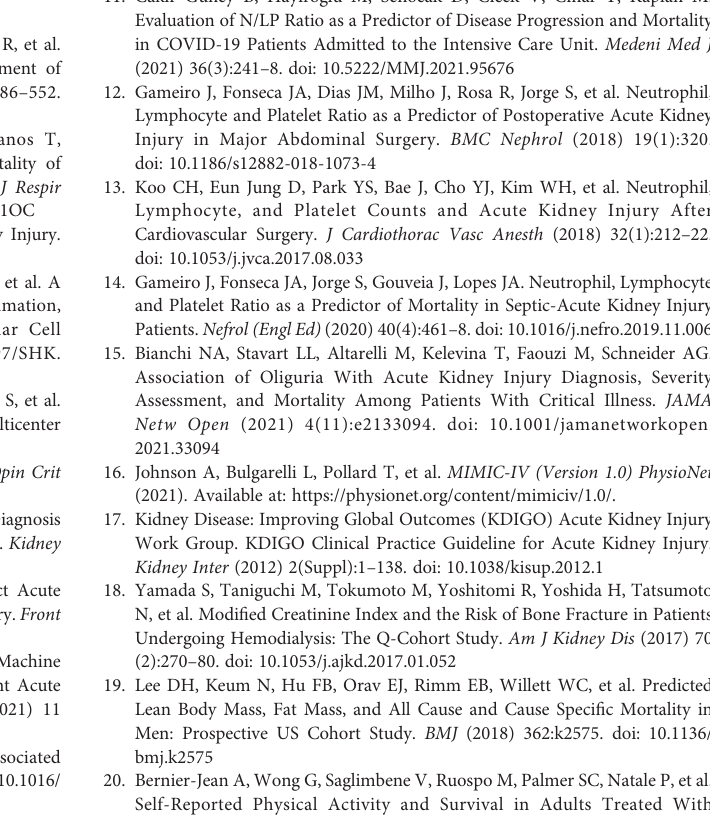
Supplementary Figure 10 | (A) The results of univariate and multivariate logistic regression. Model 1 represents the univariate analysis; Model 2 represents the multivariate analysis adjusting all covariates; Model 3 represents the multivariate analysis adjusting gender, serum bicarbonate, serum sodium, SOFA scores excluding coagulation system, Charlson comorbidity index, and the use of vasoactive medication based on the results of stepwise backward approach and collinearity analysis; (B) the results of univariate logistic analysis after inverse probability treatment weighting and the double robust estimation. Acute kidney injury is diagnosed based on urine output criteria only. Supplementary Figure 11 | Multivariable adjusted odds ratios for severe acute kidney injury (AKI) occurrence according to initial N/LP on a continuous scale by using restricted cubic splines analysis. AKI and corresponding stage are diagnosed based on urine output criteria